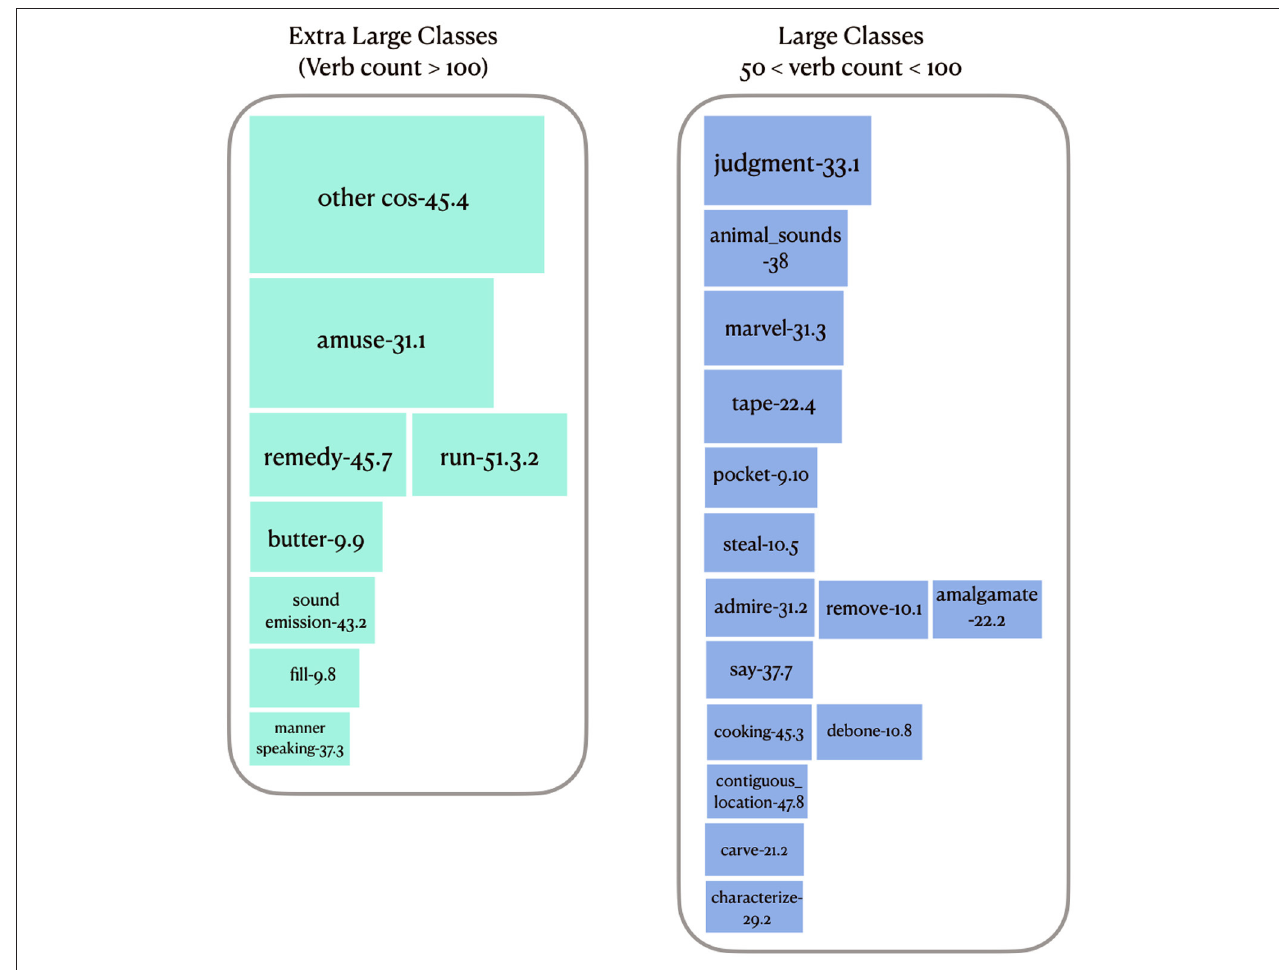
FIGURE 7 | VN classes with extra large (verb member count more than 100) and large sizes (verb member count between 50 and 100). The width of each container is equal to the size of the class in the extra large classes, and scaled to twice the size of the class in large